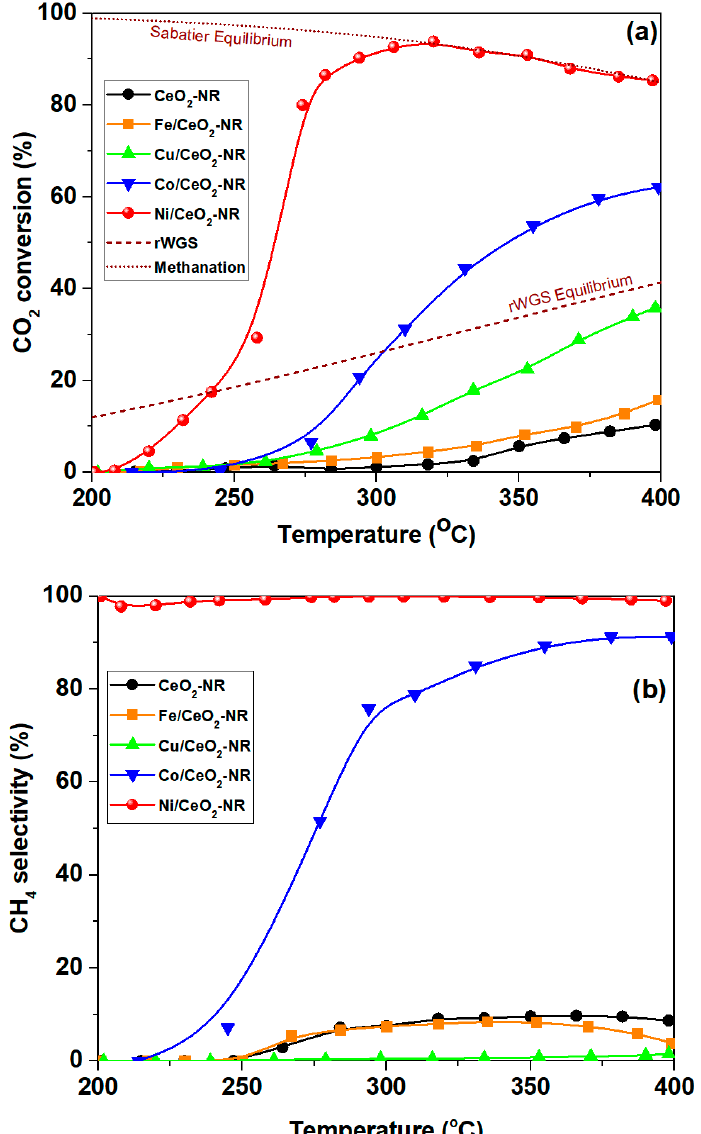
Figure 13. CO 2 conversion ( a ) and selectivity to CH 4 ( b ) for bare CeO 2 -NR and various metal-based catalysts (Fe, Cu, Co, Ni). Reaction conditions: Weight Hourly Space Velocity (WHSV) = 30,000 mL g − 1 h − 1 , H 2 :CO 2 = 4:1, P = 1 atm [39]. Dotted lines represent the corresponding equilibrium for rWGS and Sabatier reactions.